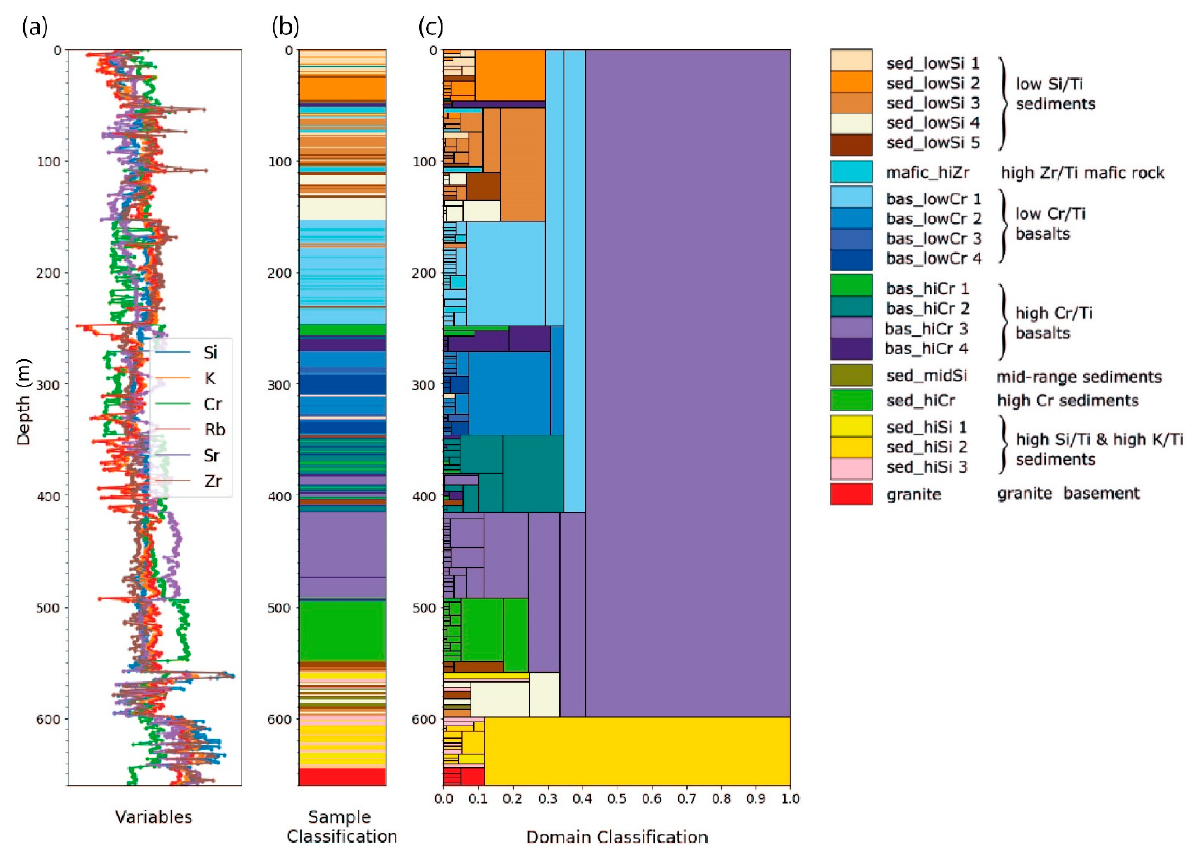
Figure 1. Example of input data and resulting plots generated from using the wavelet tessellation method to interpret a multielement geochemical dataset after Hill et al. (2020) [4]. Plots were produced using the Data Mosaic online web application (https://datamosaic.geoanalytics.group/) (access date: 28 January 2021). ( a ) Plots of scaled signals of elements of interest; ( b ) sample classification pseudolog at scale 0.0, samples are coloured by lithogeochemical classification at lowest boundary strength (domain classification) equals 0.0; ( c ) multiscale domains coloured by lithogeochemical classification.